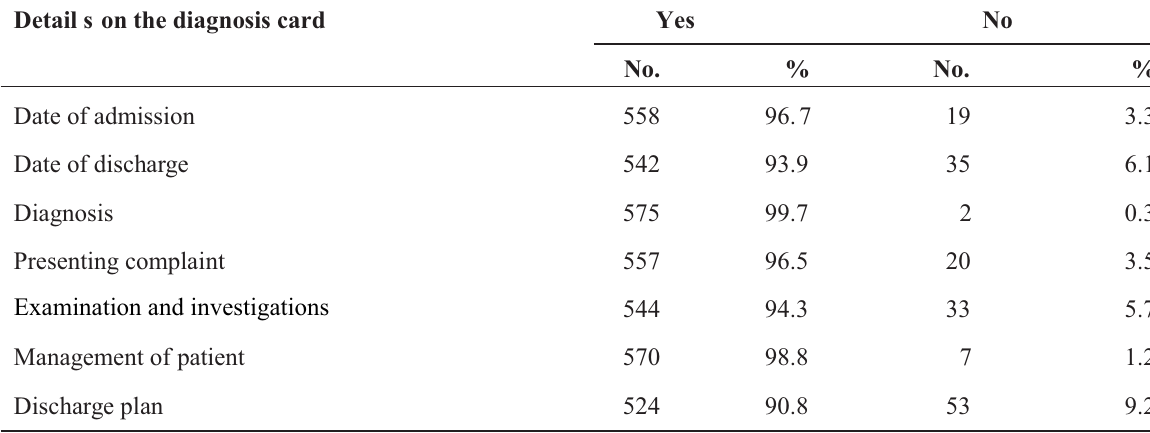
Table 4: Distribution of the information on the diagnosis card (N=577) Detail s on the diagnosis